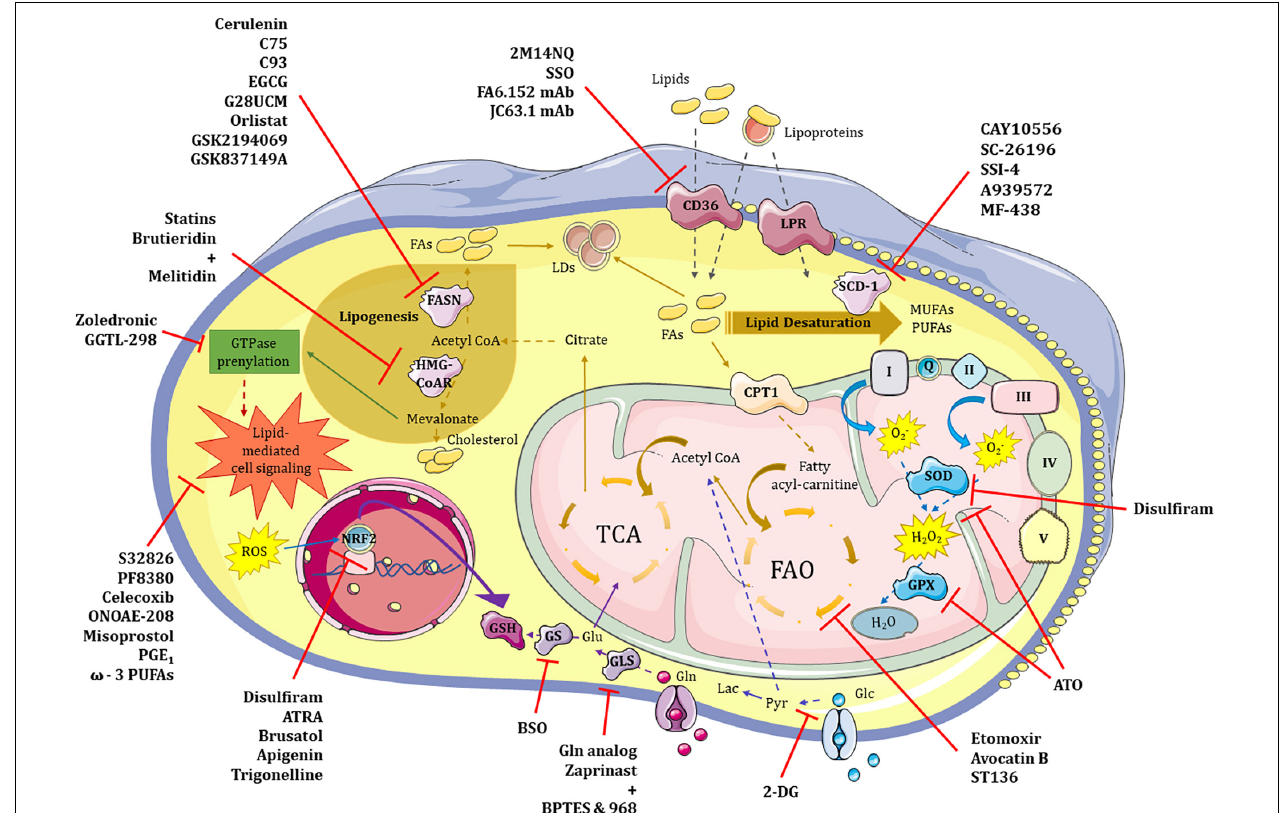
FIGURE 2 | Therapeutic targeting of glycolysis, lipid and redox metabolism in CSCs. Metabolic pathways such those involving glucose, lipids and redox balance are potentially targetable in CSCs. (1) Glycolysis . 2-DG represent the most promising therapeutic approach to neutralize highly glycolytic CSCs in combination treatments. (2) Lipid metabolism . 2M14NQ, SSO and the monoclonal antibodies FA6.152 and JC63.1 can block CD36 activity; substances like Etomoxir, Avocatin B or ST136 block fatty acid oxidation (FAO) in the mitochondria; FASN can be inhibited by drugs such as Cerulenin, C75, C93, EGCG, G28UCM, Orlistat, GSK2194069 or GSK837149A; while HMG-CoAR enzyme may be inhibited by either Statins or the combination of Brutieridin plus Melitidin; GTPase prenylation pathway in which mevalonate is involved can be targeted by both Zoledronic acid and GGTL-298; and different steps of the lipid-mediated cell signaling may